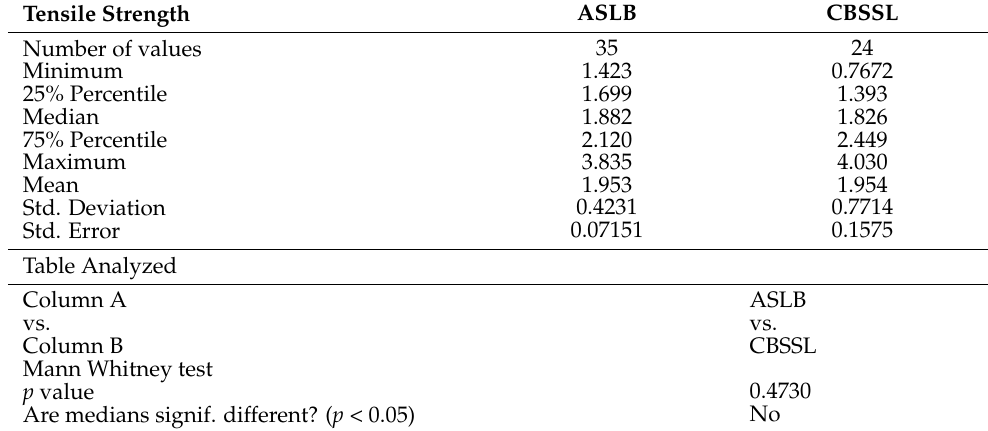
Table A3. Tensile strength: active vs. conventional stainless steel ligature brackets. Tensile Strength